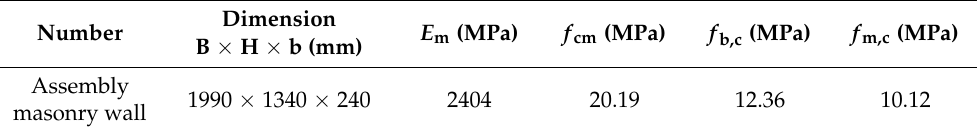
Table 2. Parameters of test